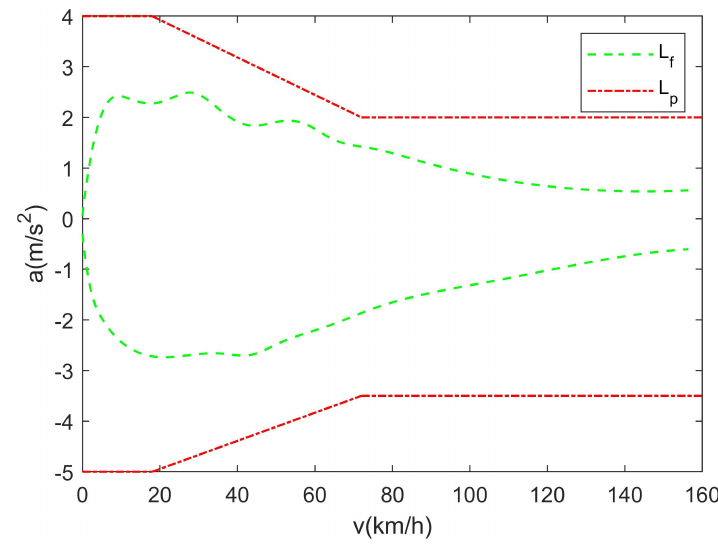
Figure 6. Full-score and passing line of